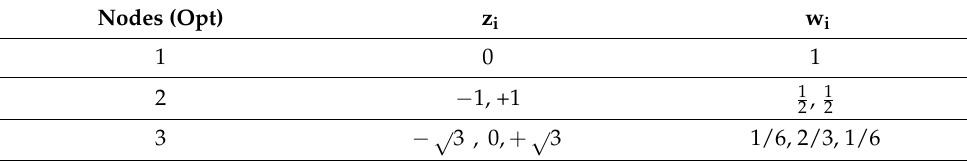
Table 2. Abscissas and weights for the standard normal distribution. Nodes